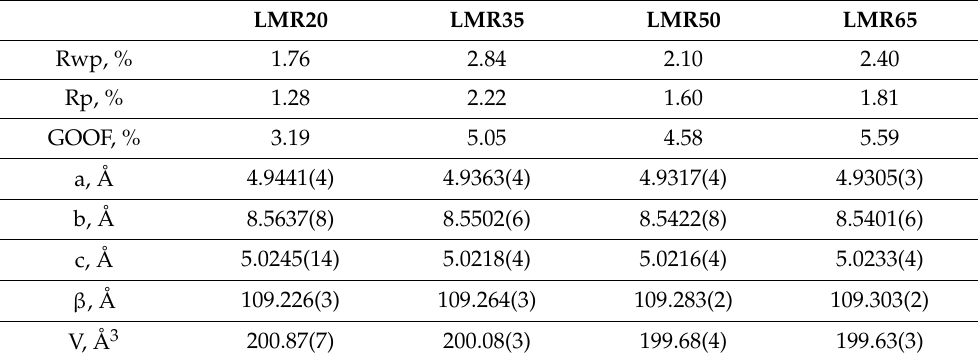
Figure 2. XRD patterns for the cathode materials with different compositions: ( a ) LMR20, ( b ) LMR35, ( c ) LMR50, ( d ) LMR65. Table 3. Crystallographic data and the unit cell parameters from the Rietveld refinement ( C 2/ m space group) for the cathode materials.